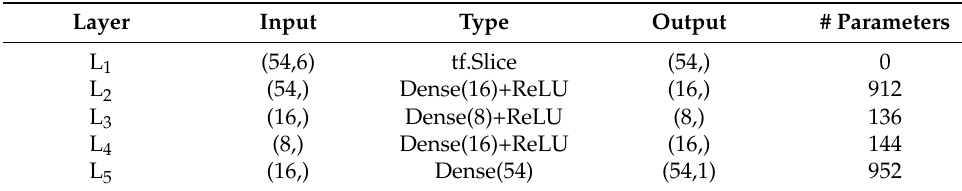
Table 2. Autoencoder layers’ characteristics.